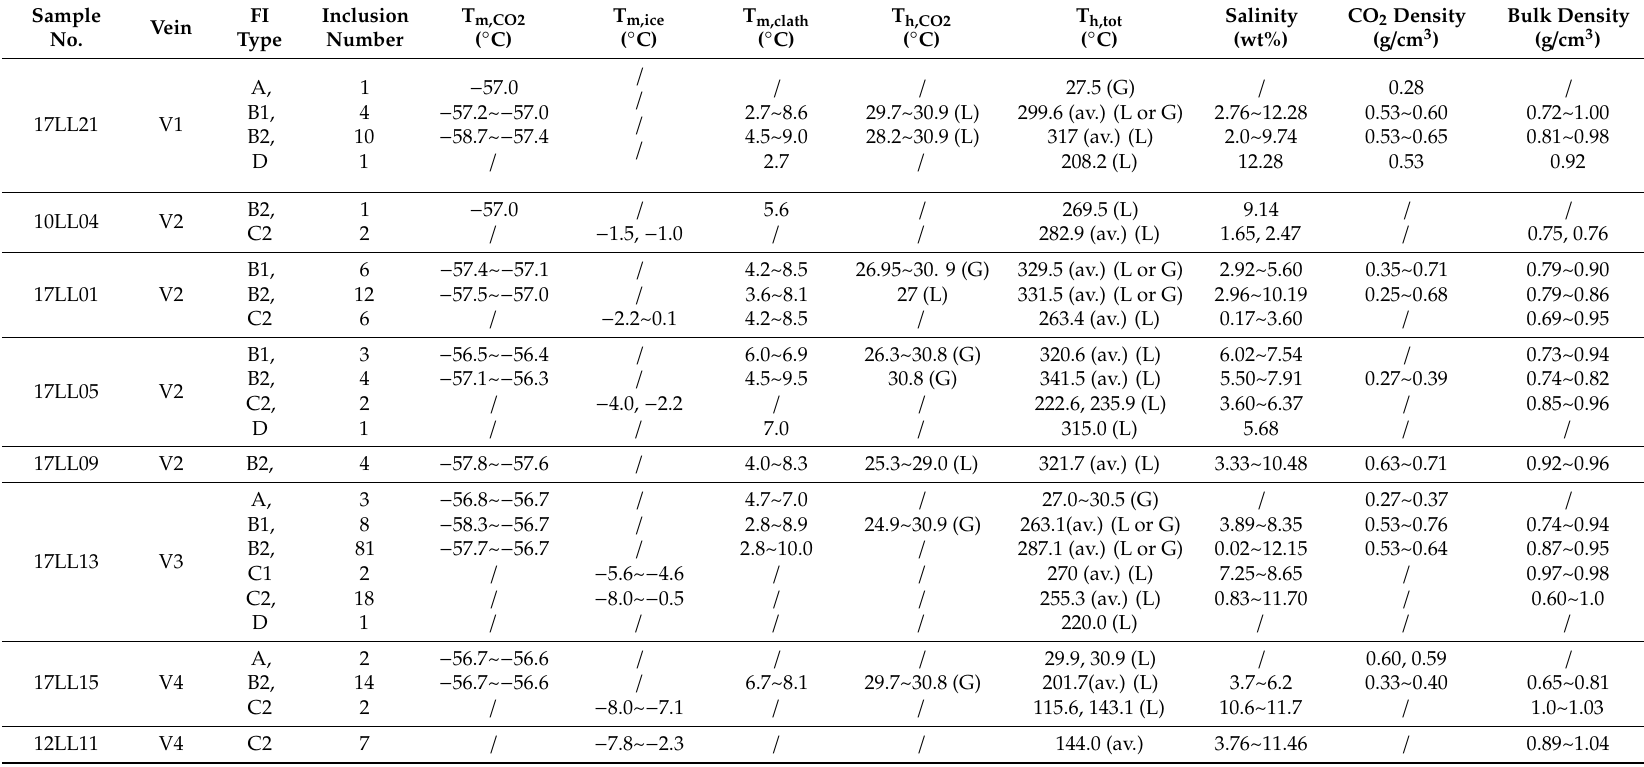
Table 2. Microthermometric results of fluid inclusions at Linglong gold